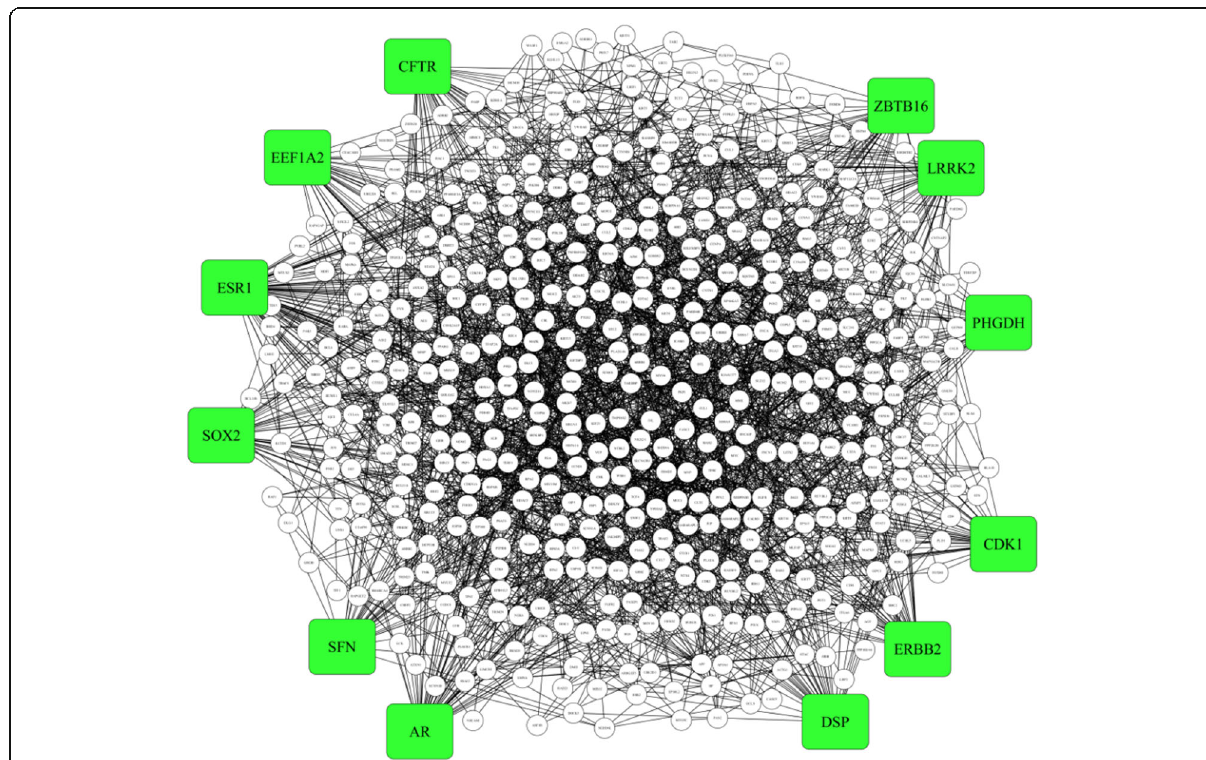
Fig. 2 Protein – protein interaction network with 474 nodes and 2233 connections. Highlighted green color nodes indicate Hub genes of the network